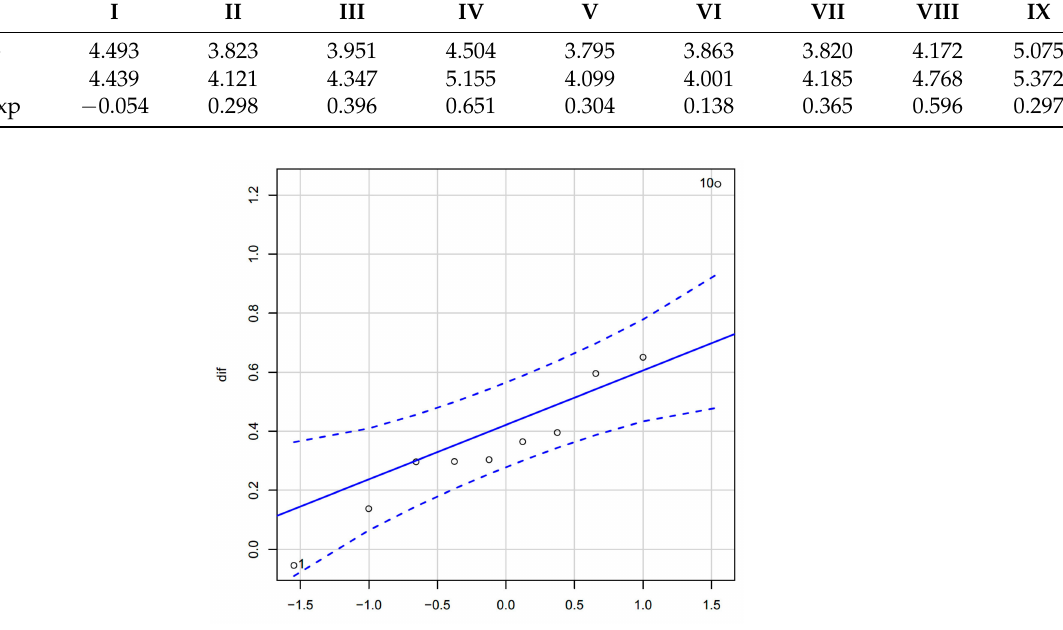
Figure 8. Normal Q–Q plot for F (cid:48) a –F a